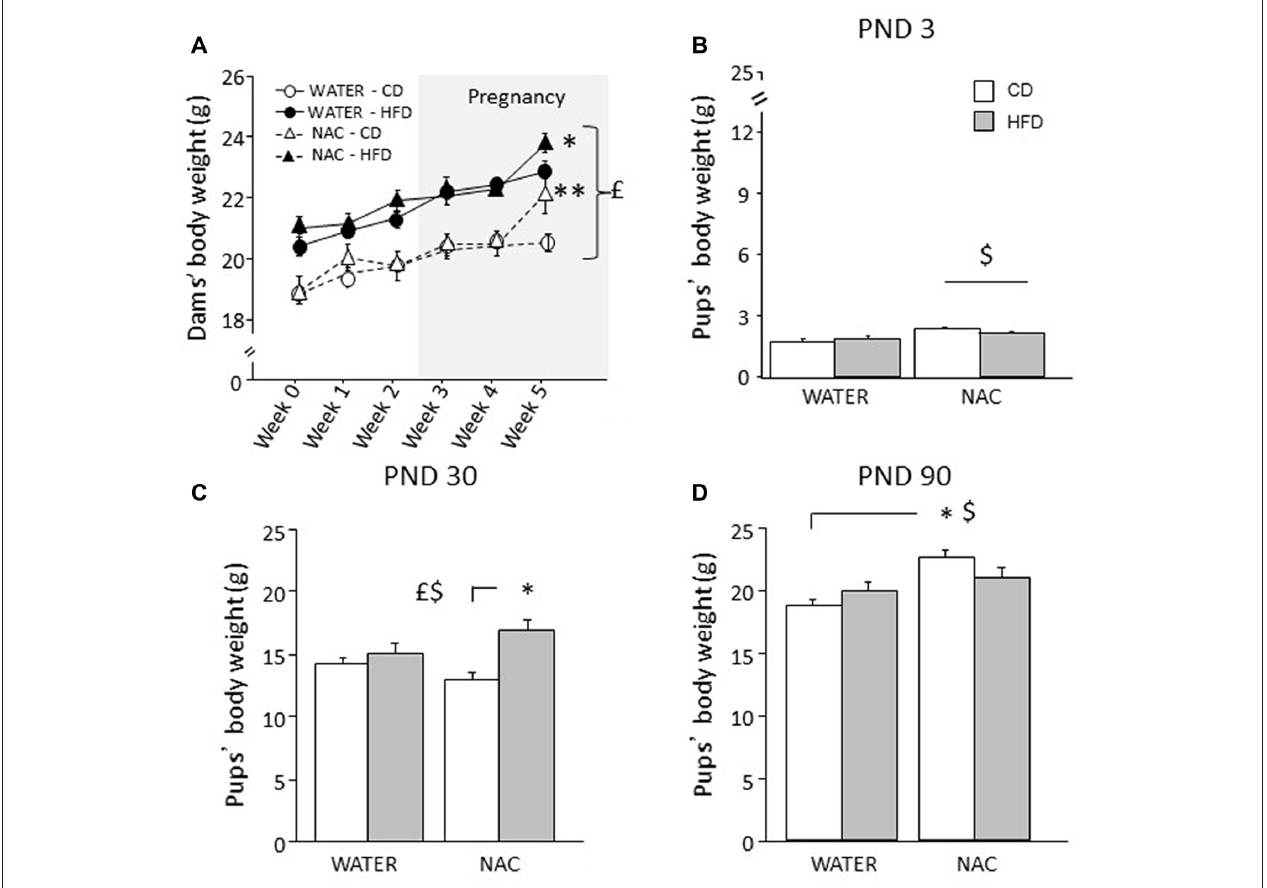
FIGURE 2 | Body weight of dams and offspring. (A) HFD increased dams’ body weight during both peri-conceptional time and pregnancy (gray shade) moreover, NAC increased dams’ body weight on week 5. (B) Prenatal NAC increased pups’ body weight on PND 3; (C) on PND 30 HFD overall increased pups’ body weight particularly when in combination with NAC (D) this effect was reverted on PND 90. Data are mean ± SEM (dams) and + SEM (pups); $ p < 0.05, main effect of NAC; £ p < 0.05, main effect of HFD; ∗∗ p < 0.01 NAC-CD vs. NAC-HFD (A) ; ∗ p < 0.05, NAC-HFD vs. WATER-HFD (A) ; NAC-HFD vs. NAC-CD (C) ; NAC-CD vs. WATER-CD (D)